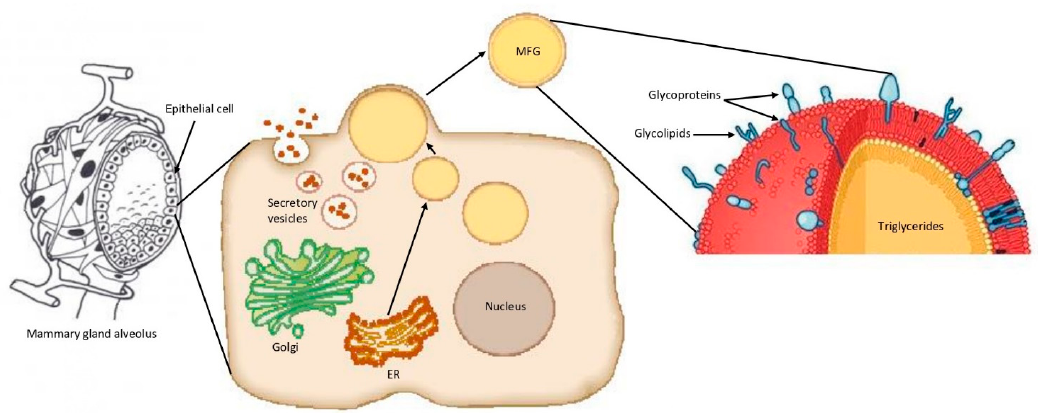
Figure 1. Schematic representation of milk fat globule (MFG) formation. The microlipid droplets (yellow circles) are extruded from the endoplasmatic reticulum (ER) in the cytoplasm of the mammary gland epithelial cell to reach the apical plasma membrane, where they are extruded in the alveolar lumen as MFGs. Adapted from Reece, 2004 [32]; Horseman et al., 2014 [33]; and Wikipedia